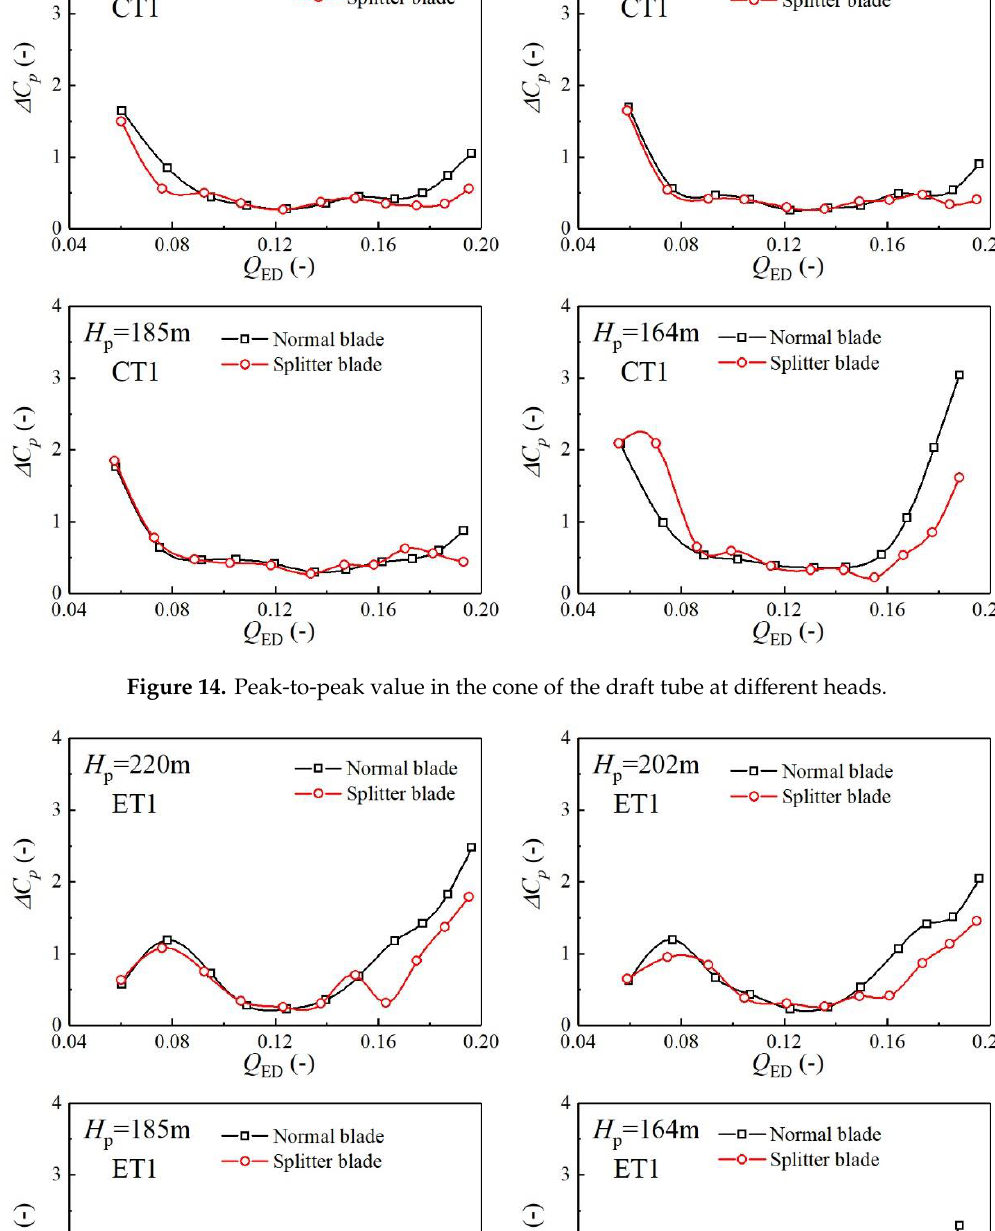
Figure 15. Peak-to-peak values for elbow of draft tube at different heads.